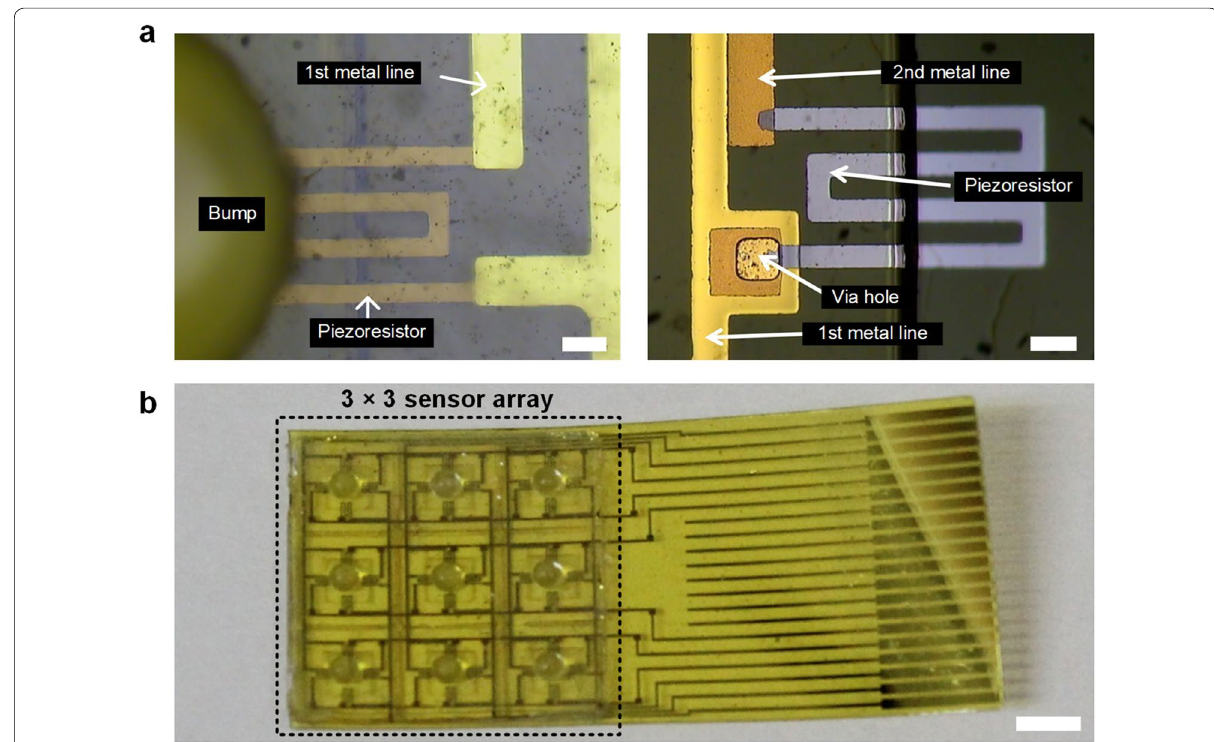
Fig. 4 As‑fabricated polymer‑based tactile sensor array. a Optical microscope images showing the top and bottom views of the sensor (scale bar: